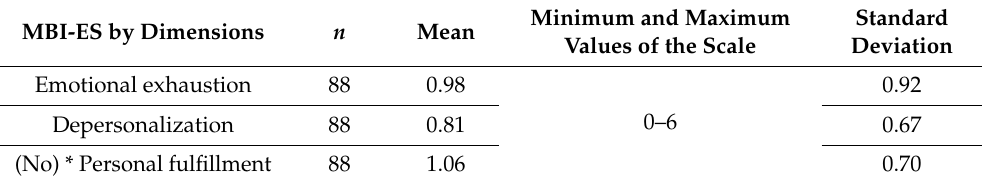
Minimum and Maximum Standard Values of the Scale Deviation 0.92 0–6